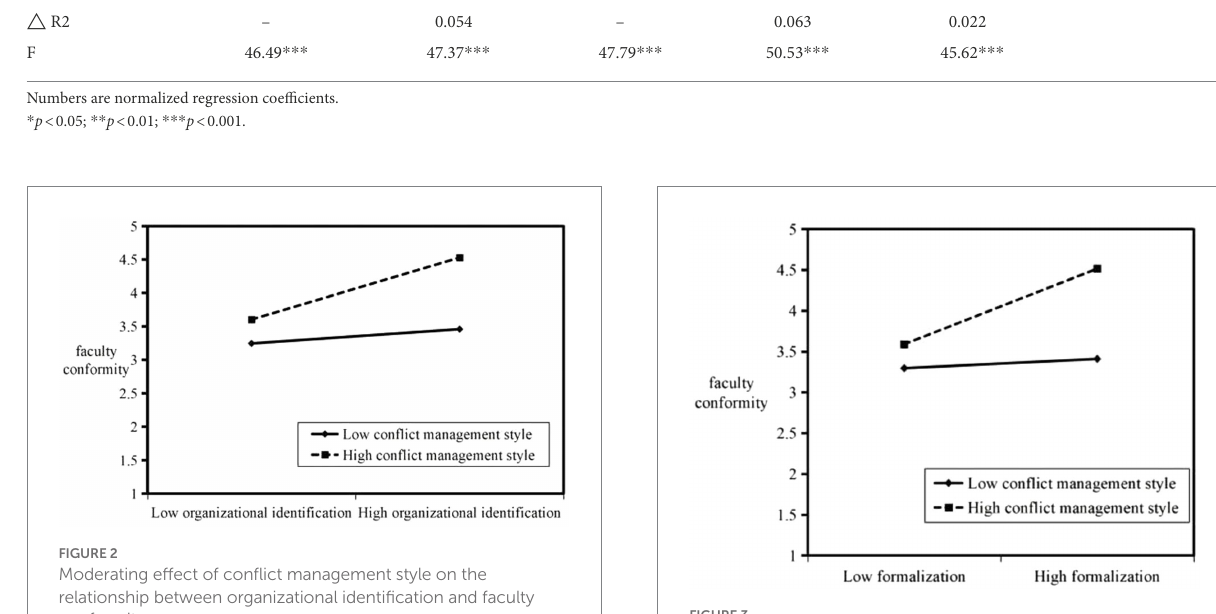
Moderating effect of conflict management style on the relationship between formalization and faculty